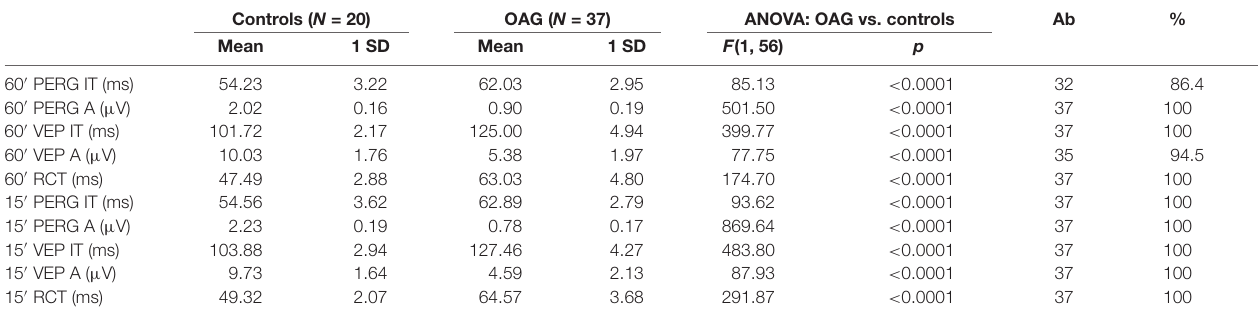
TABLE 1 | Mean values of 60 (cid:48) and 15 (cid:48) pattern electroretinogram (PERG) P50 implicit time (IT) and P50-N95 amplitude (A), visual evoked potentials (VEP) P100 IT and N75-P100 A detected in controls and in patients with open-angle glaucoma (OAG). Controls ( N = 20) OAG ( N = 37) ANOVA: OAG vs. controls Ab % Mean 1 SD Mean 1 SD F (1, 56) p 60 (cid:48) PERG IT (ms)